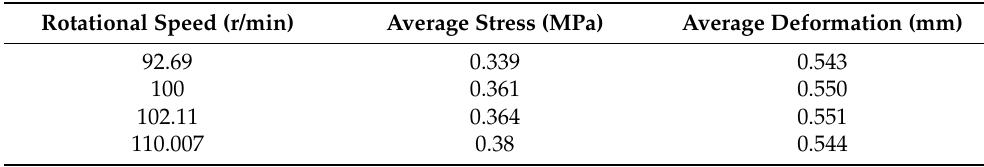
Table 3. Average stress and average